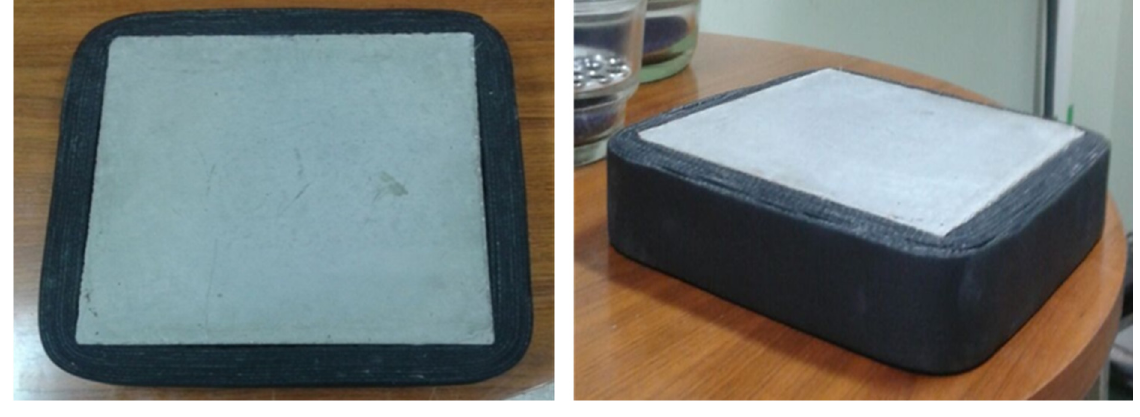
Figure 3. Specimens awaiting preparation and